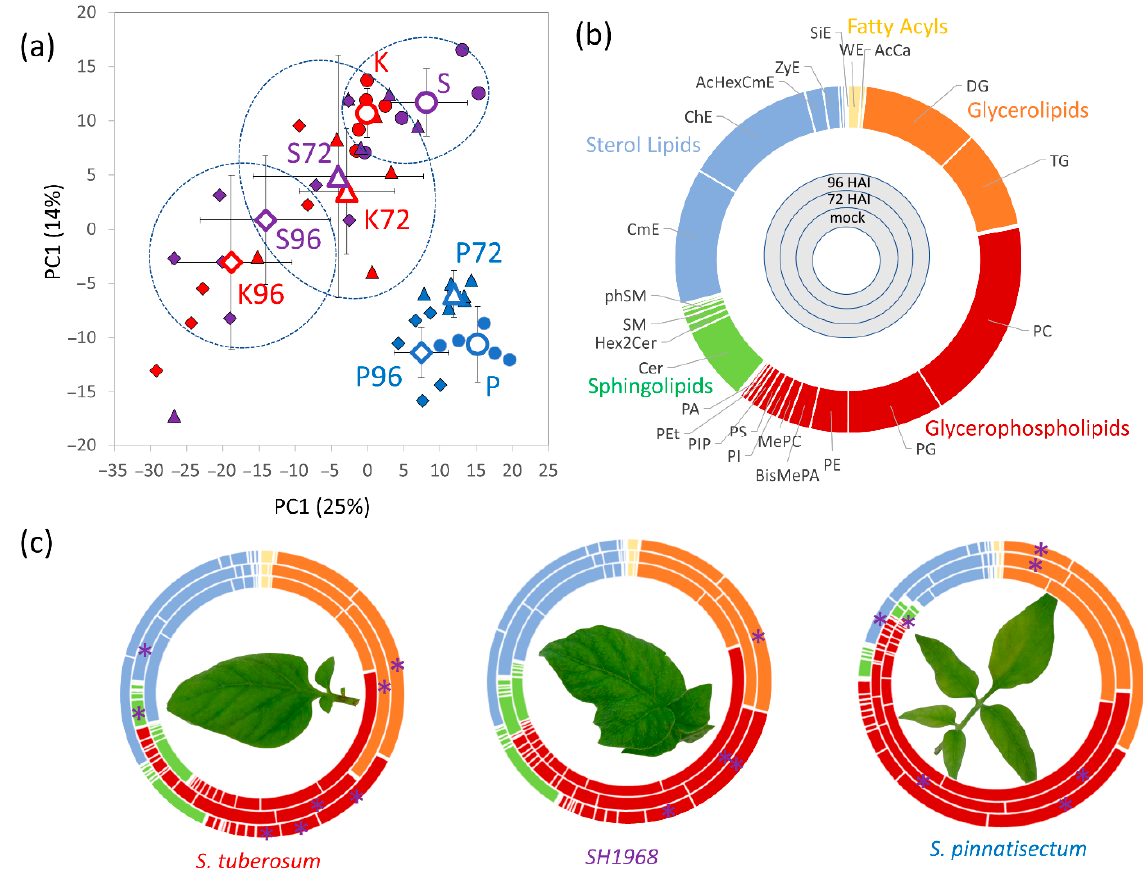
Figure 5. Lipidome profiling confirmed significant alterations in lipidome composition in response to P. infestans inoculation. ( a ) Separation of lipidome profiles by PCA, including the means and standard deviations, ( b ) estimated composition of S. tuberosum leaf lipidome, and ( c ) lipidome response to inoculation. Asterisks indicate statistically significant differences compared to the mock for lipid classes representing at least 2% of the estimated lipid content (Student’s t ‐ test, p < 0.05). K, S. tuberosum cv. Kerkovsky rohlicek; P, S. pinnatisectum ; S, hybrid SH1968; DG, diglyceride; TG, triglyceride; PC, phosphatidylcholine; PG, phosphatidylglycerol; PE, phosphatidylethanolamine; BisMePA, bis-methyl phosphatidic acid; MePC, methyl phosphatidylcholine; PI/PIP, phosphatidylinositol; PS, phosphatidylserine; PEt, phosphatidylethanol; PA, phosphatidic acid; Cer, ceramide; Hex2Cer, glycosphingolipids, simple Glc series; SM, sphingomyelin; phSM, sphingomyelin(phytosphingosine); CmE, campesterol ester; ChE, cholesterol ester; AcHexCmE, AcylGlcCampesterol ester; ZyE, zy- mosterol ester; SiE, sitosterol ester; WEs, wax esters; AcCa, acyl carnitine. For details, see Supplementary Materials, Table